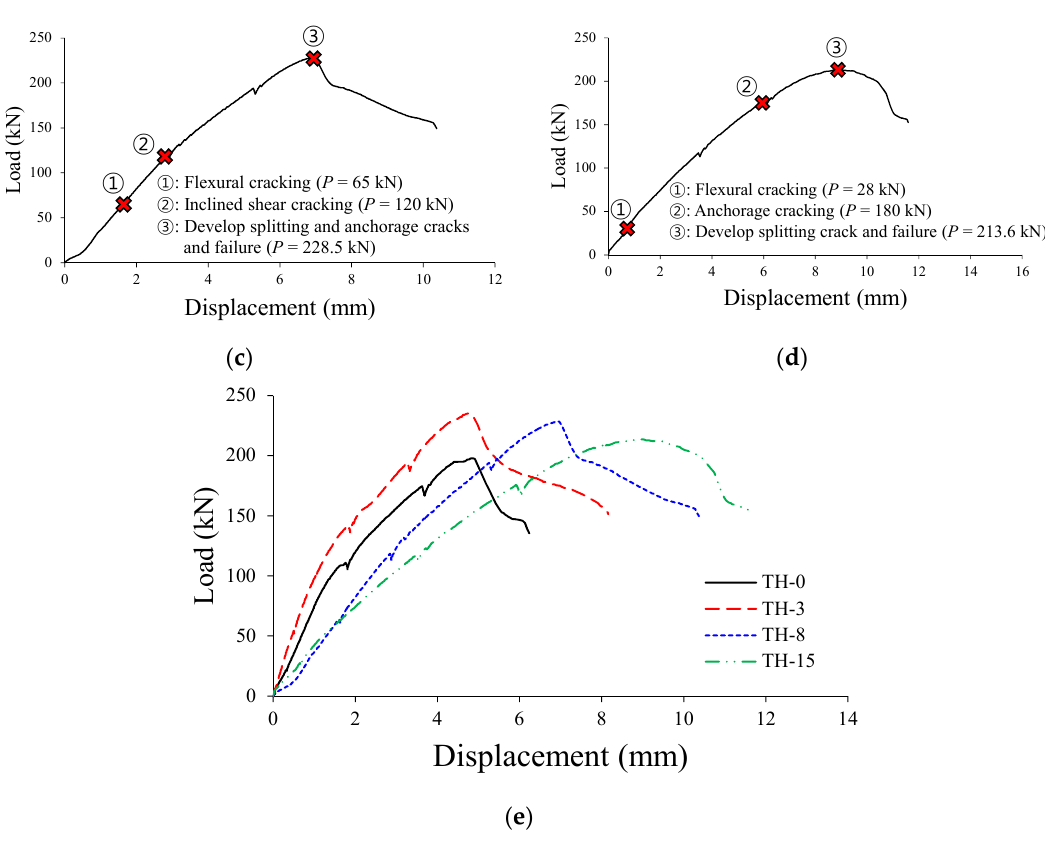
Figure 9. Load-displacement responses of TH series specimens. ( a ) TH-0 specimen; ( b ) TH-3 specimen; ( c ) TH-8 specimen; ( d ) TH-15 specimen; ( e ) Comparison of TH series test results.